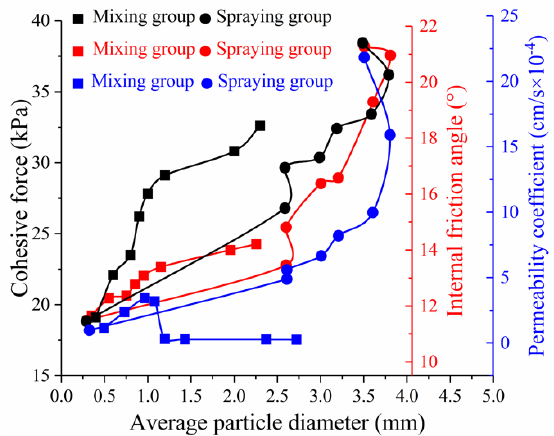
Figure 11. The relationship between the parameters.